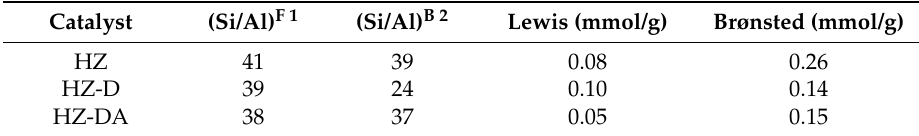
Figure 5. 29 Si NMR spectra of tested catalysts. The broken lines are the deconvolution based on a Gaussian function. The relative compositions of Si(0Al), Si(1Al), and Si(3OH) are presented. Table 2. Compositions and acid concentrations of Lewis and Brønsted acid sites.